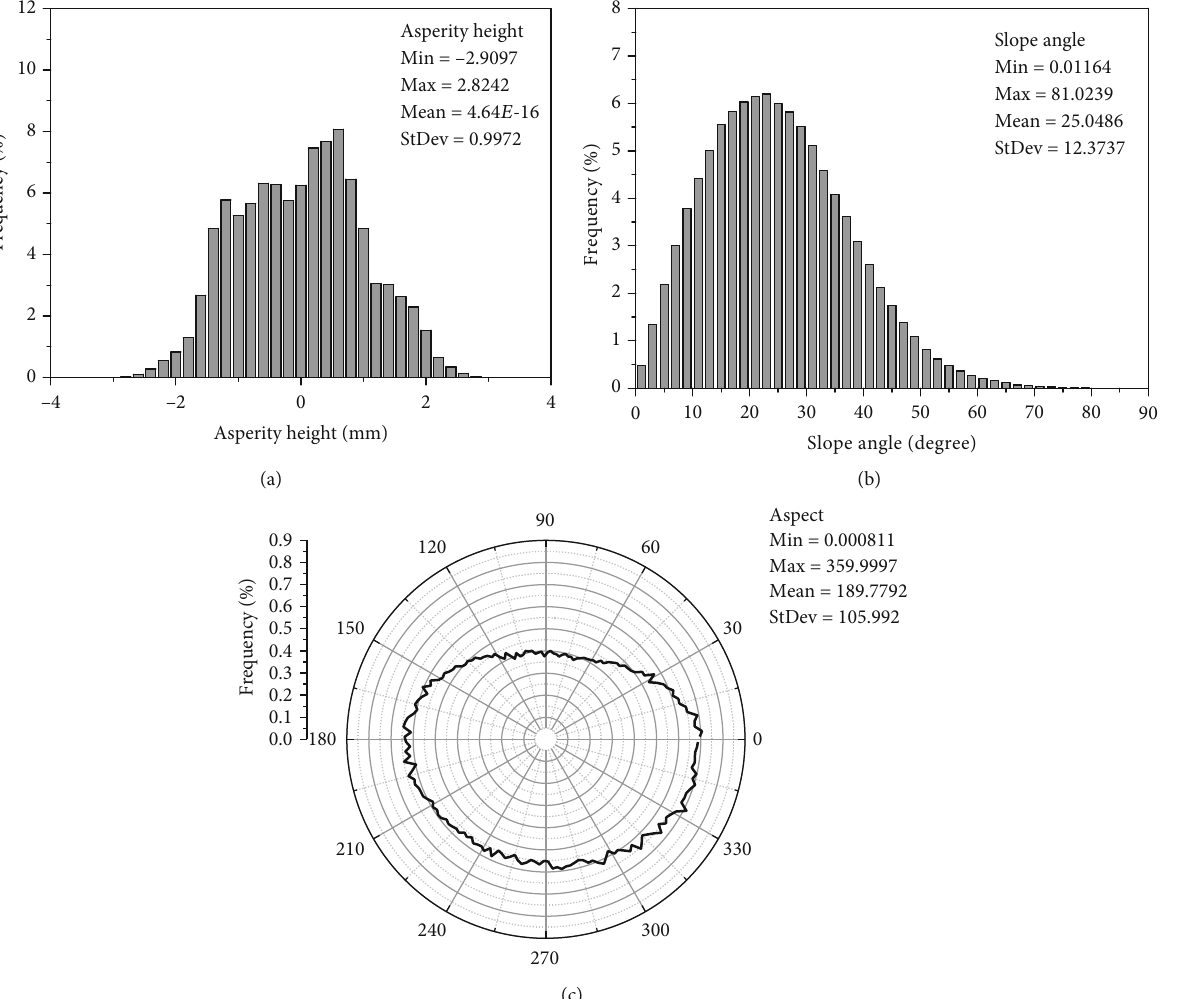
Figure 2: Asperity height, slope angle, and aspect direction distributions of rough-walled rock fracture